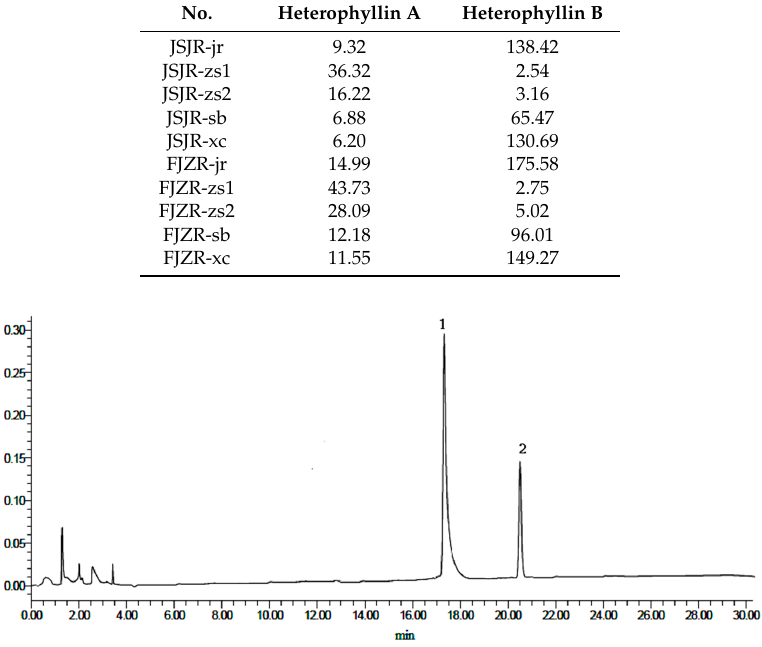
Figure 5. HPLC chromatograms of mixed standards. ( 1 ) Heterophyllin B, and ( 2 ) heterophyllin A.